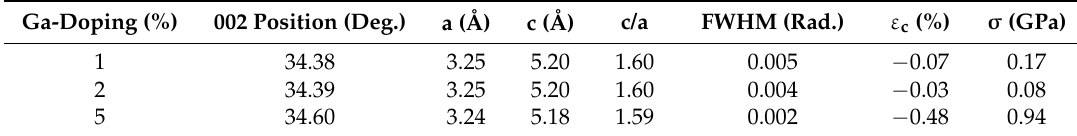
Figure 6. XRD of: ( a ) 1%; ( b ) 2%; and ( c ) 5% GZRs. Table 1. Lattice parameters of GZRs. Table 1. Lattice parameters of